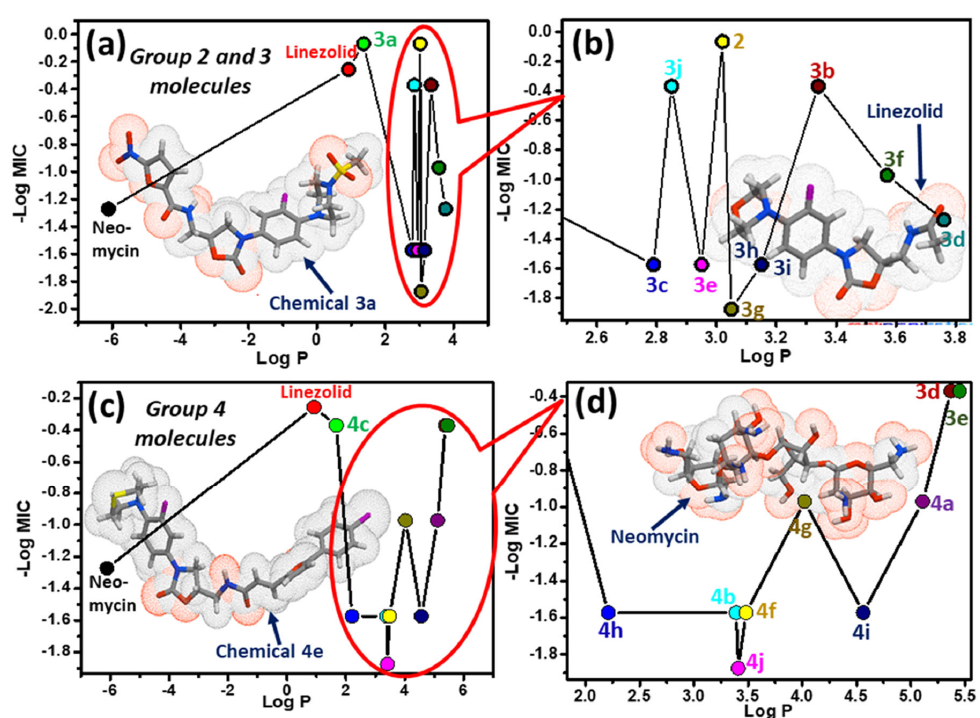
Figure 5. One-descriptor (log P ) analysis of the potential antibacterial agents—minimum inhibitory concentration ( − log MIC) vs. log P. (a) For molecules of group 2 and 3 (b) Zoomed view of the red circled molecules of panel ‘a’ (c) For molecules of group 4 (d) Zoomed view of the red circled molecules of panel ‘c’.